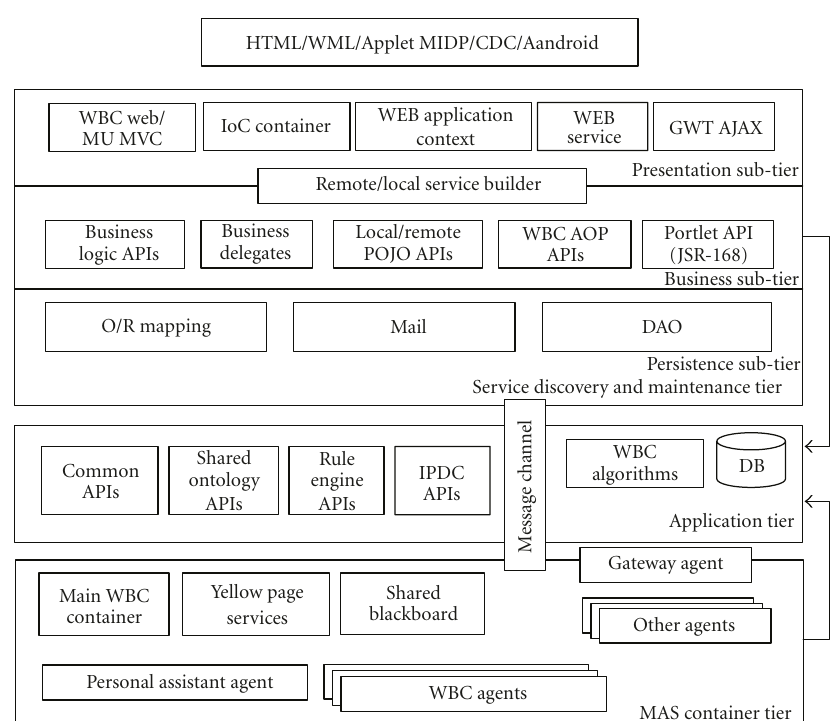
Figure 8: The WBC application enabler sublayer’s architecture.